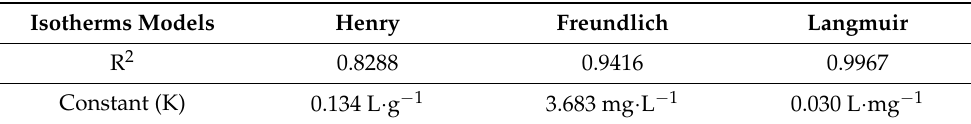
Table 3. Isotherm models applied to the biosorption process and R 2 .